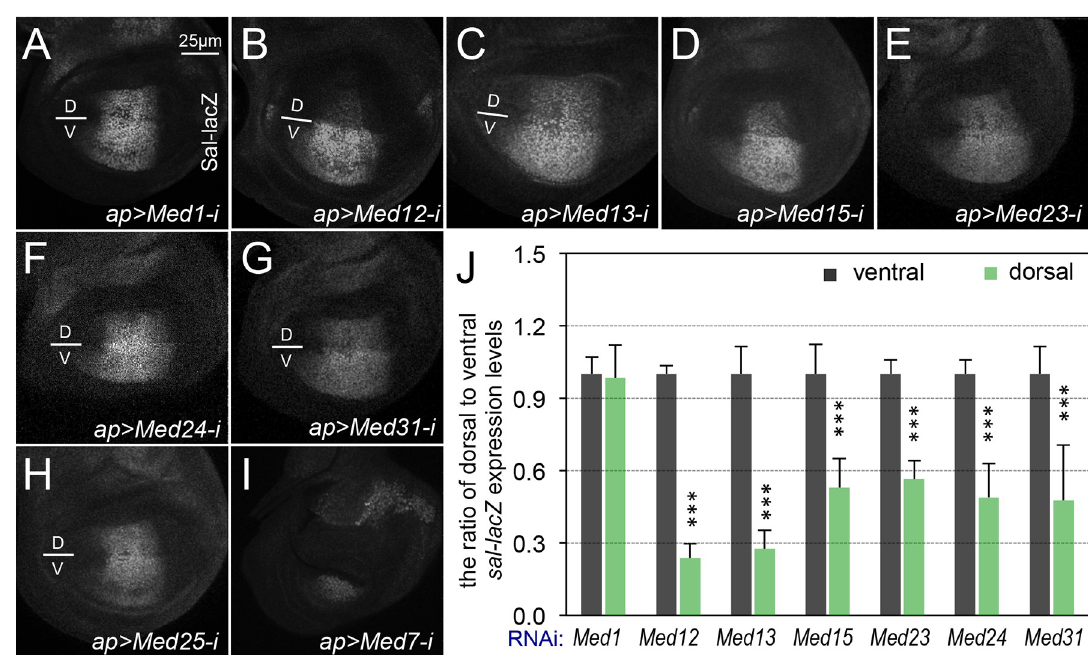
Fig 7. Effects of the additional Mediator subunits on the expression of the sal-lacZ reporter. Representative confocal images of anti- β -Gal staining of wing discs of the following genotypes: (A) ap-Gal4 , sal-lacZ/+; UAS-Med1-RNAi/+ ; (B) ap-Gal4 , sal-lacZ/+; UAS-Med12-RNAi/+ ; (C) ap-Gal4 , sal-lacZ/+; UAS-Med13-RNAi/+ ; (D) ap-Gal4 , sal-lacZ/+; UAS-Med15-RNAi/+ ; (E) ap-Gal4 , sal- lacZ/+; UAS-Med23-RNAi/+ ; (F) ap-Gal4 , sal-lacZ/+; UAS-Med24-RNAi/+ ; (G) in ap-Gal4 , sal-lacZ/+; UAS-Med31-RNAi/+ ; (H) ap- Gal4 , sal-lacZ/UAS-Med25-RNAi ; and (I) ap-Gal4 , sal-lacZ/+; UAS-Med7-RNAi/+ . (J) Quantification of Sal-lacZ expression. The black columns represent the average of Sal-lacZ expression in the ventral compartment of five wing discs of the indicated genotypes (N = 5 for each genotype), and light green columns represent the measurements in the dorsal compartments. Scale bar in A: 25 μ m. For (H) and (I), at least five wing discs were examined for each genotype.